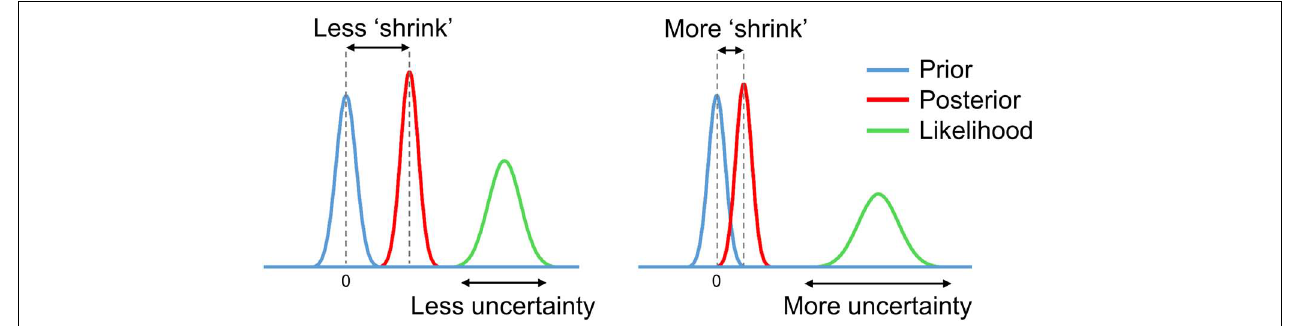
FIGURE 3 | Schematic of Bayesian updating with the ‘global shrinkage’